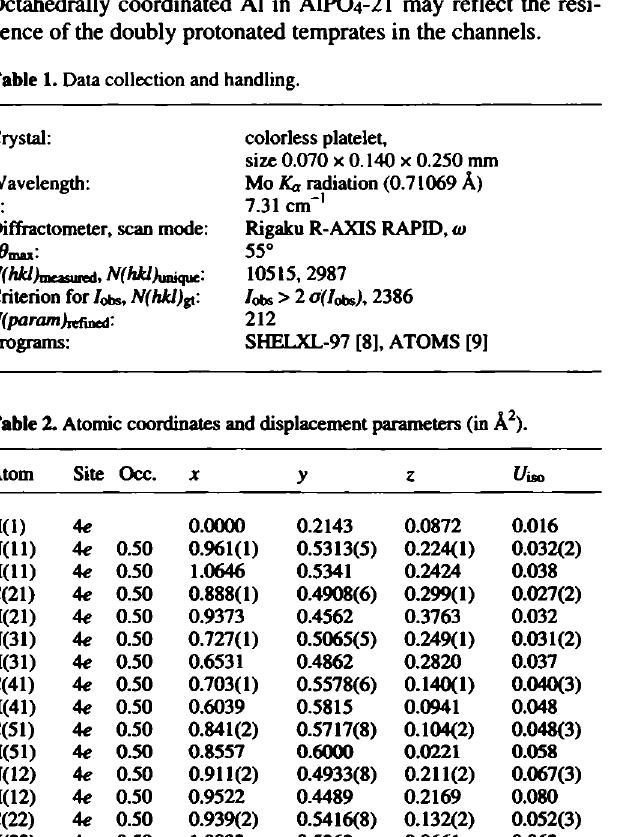
Table 3. Atomic coordinates and displacement parameters (in À 2